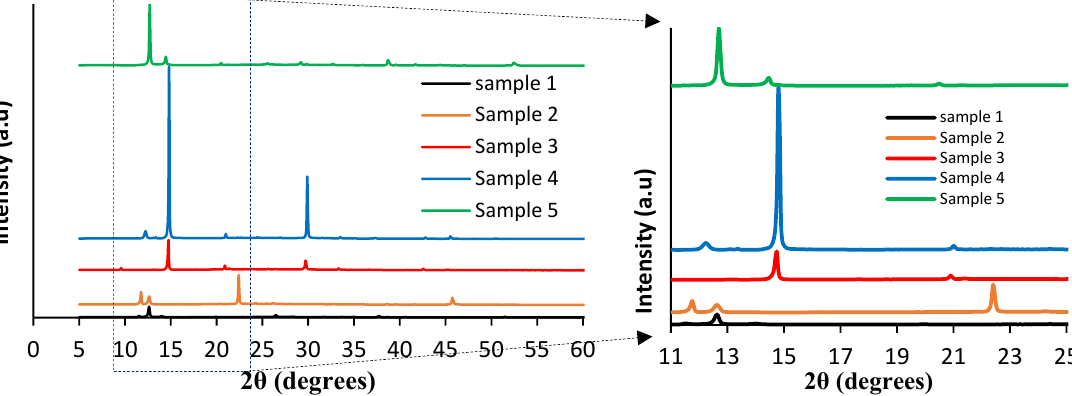
Figure 10. ( Left ) XRD patterns spectra of the perovskite active layers prepared with different composition; ( right ) XRD patterns focused on the range of 11° to 16°.